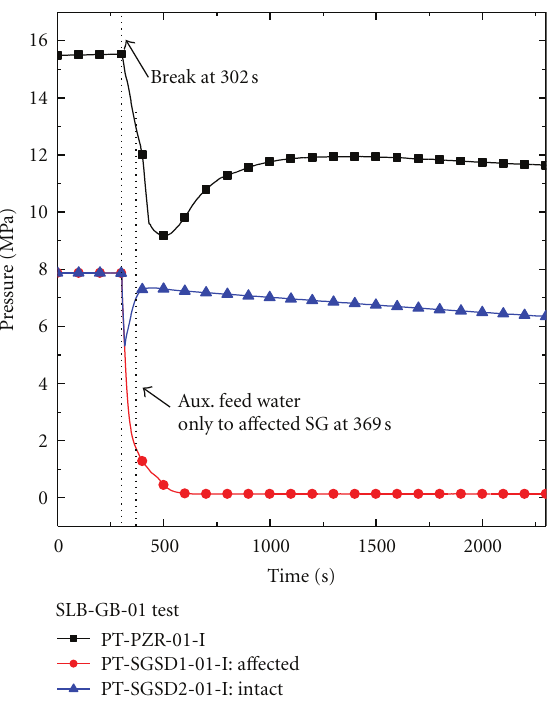
Figure 27: Pressure trends of the guillotine break of the steam